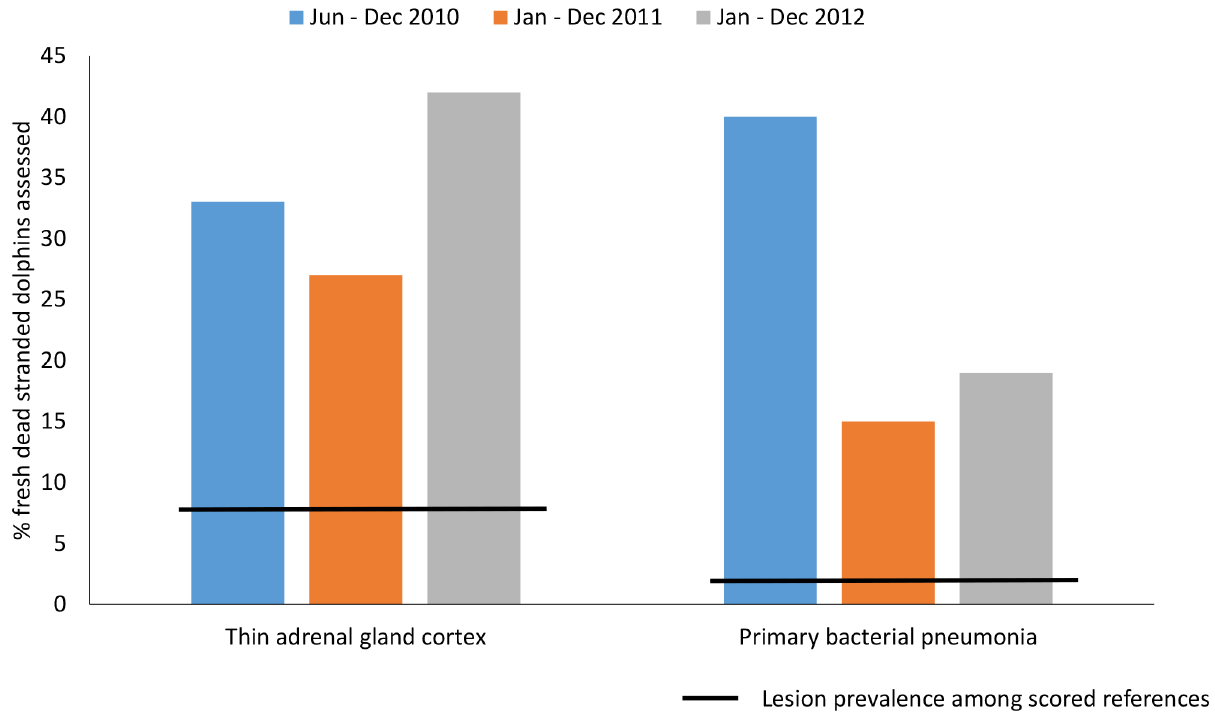
Fig 2. Prevalence of key histologic lesions among fresh dead, stranded common bottlenose dolphins ( Tursiops truncatus ) by year in Louisiana, Mississippi & Alabama: June 2010 to December 2012. The gray line represents the percentage of lesion prevalence among standardly scored reference dolphins. All years had prevalence of lesions greater than the reference group ( P >